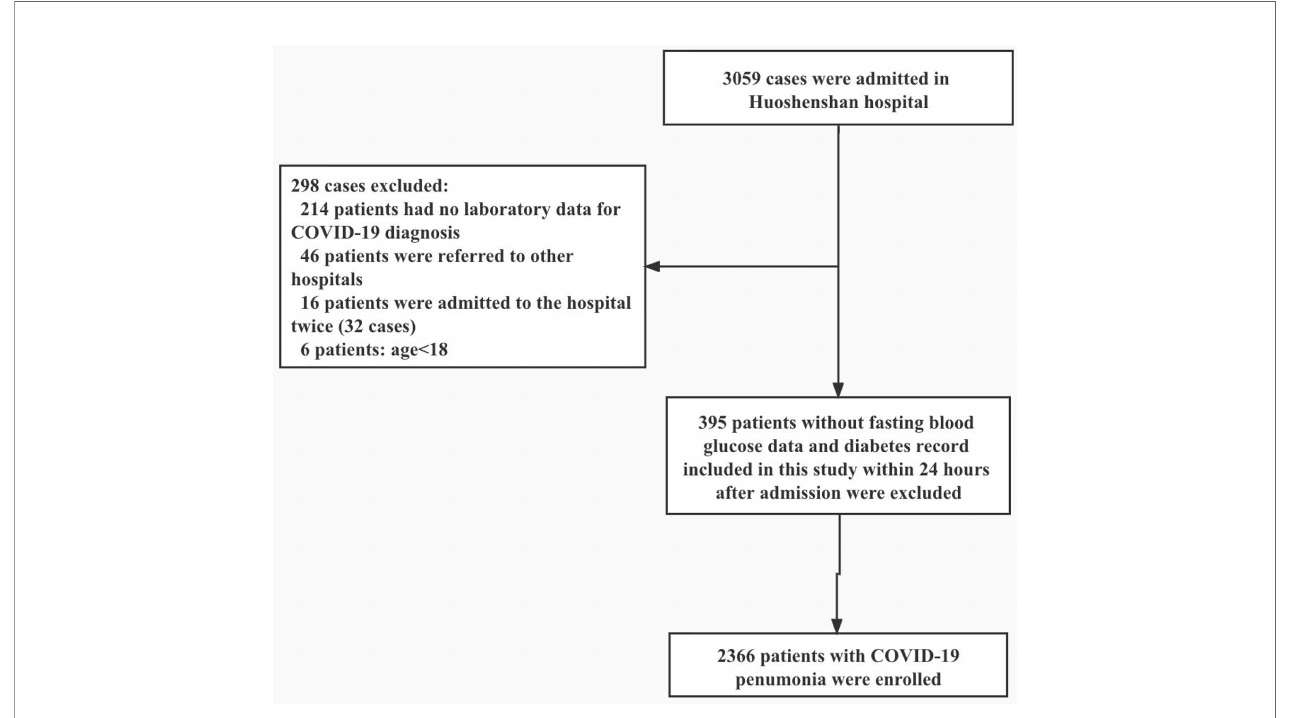
FIGURE 1 | Flowcharts for the selection of study